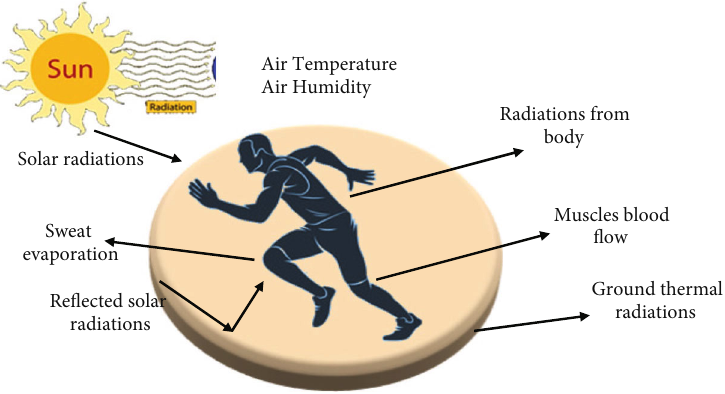
Figure 4: The phenomenon of convective heat transfer.